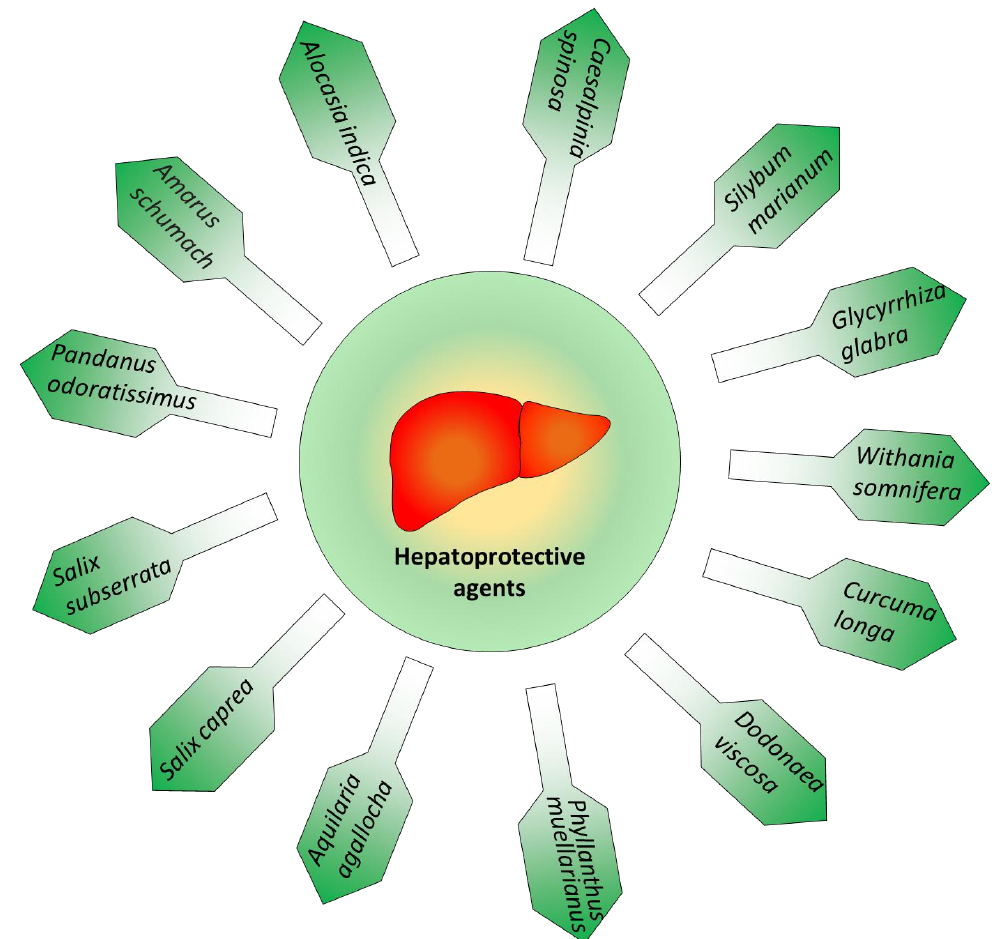
Figure 4. Various medicinal plants possessing potential hepatoprotective activities.